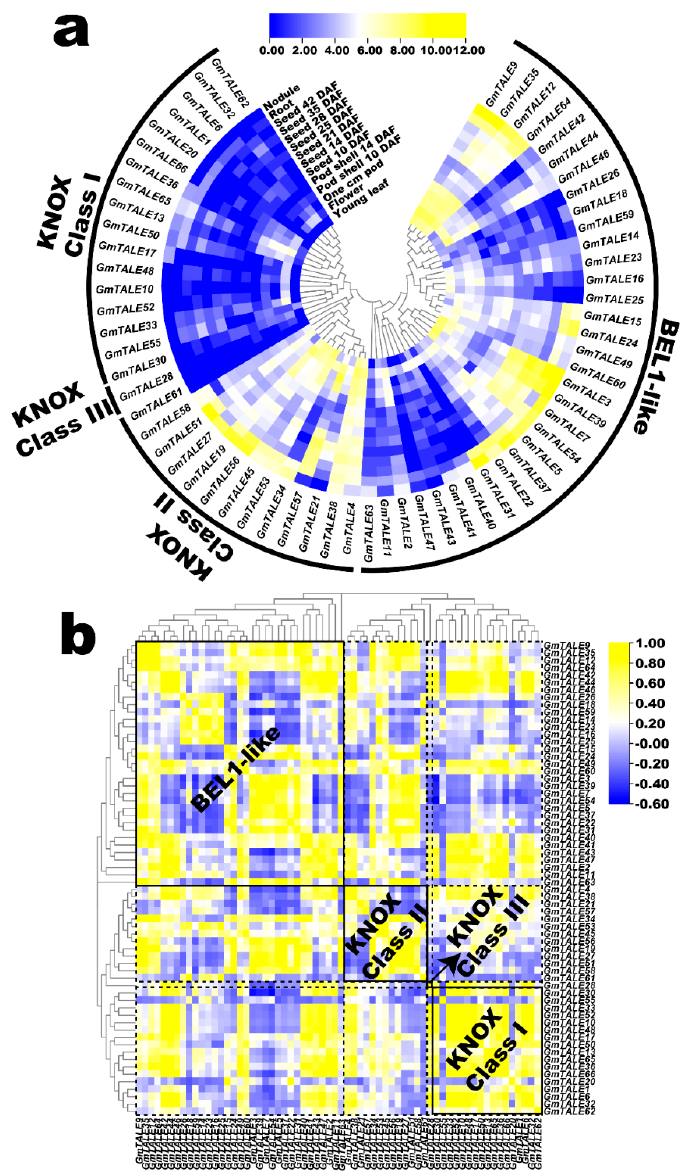
Figure 7. Expression profiling of GmTALE genes in various tissues or organs during soybean de- velopment. ( a ) Hierarchically clustered expression profiles of GmTALE genes in various tissues or organs during soybean development. DAF: days after flowering; cm: centimeter. ( b ) Gene expression correlation heatmap of the expressed GmTALE genes in various tissues or organs during soybean development. Yellow: positively correlated; blue: negatively correlated. The phylogenetic tree was as built used the maximum likelihood (ML) method with the best scoring JTT + G